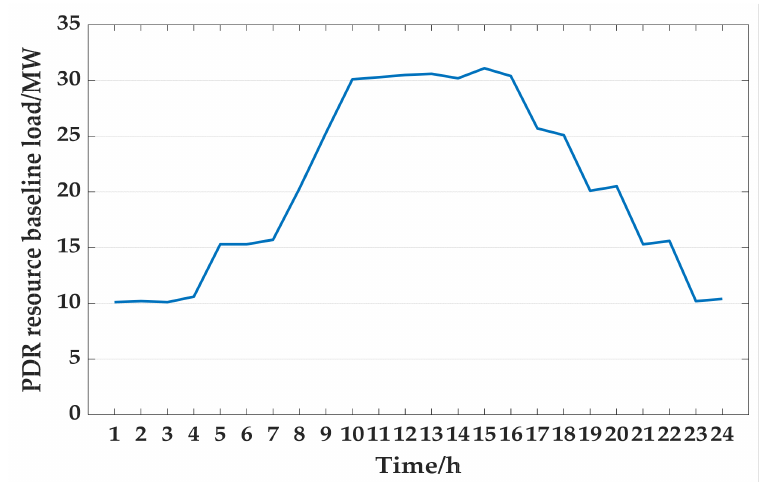
Figure A2. PDR resource baseline load